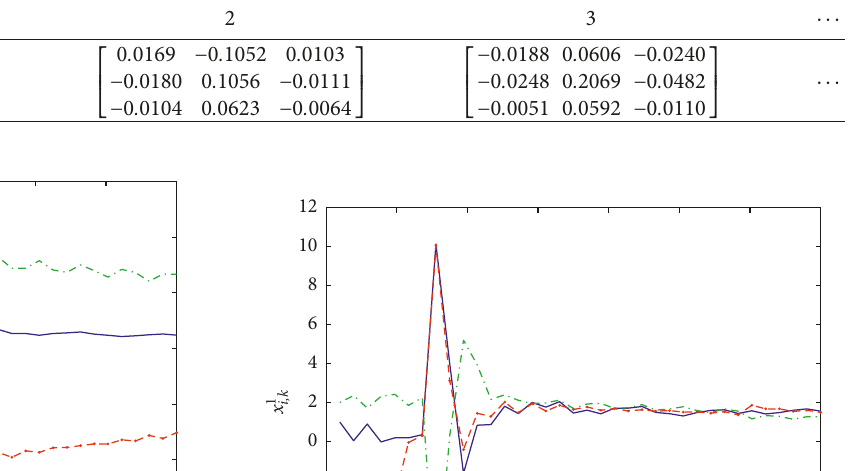
Table 2: The output-feedback controller gains at each time step.